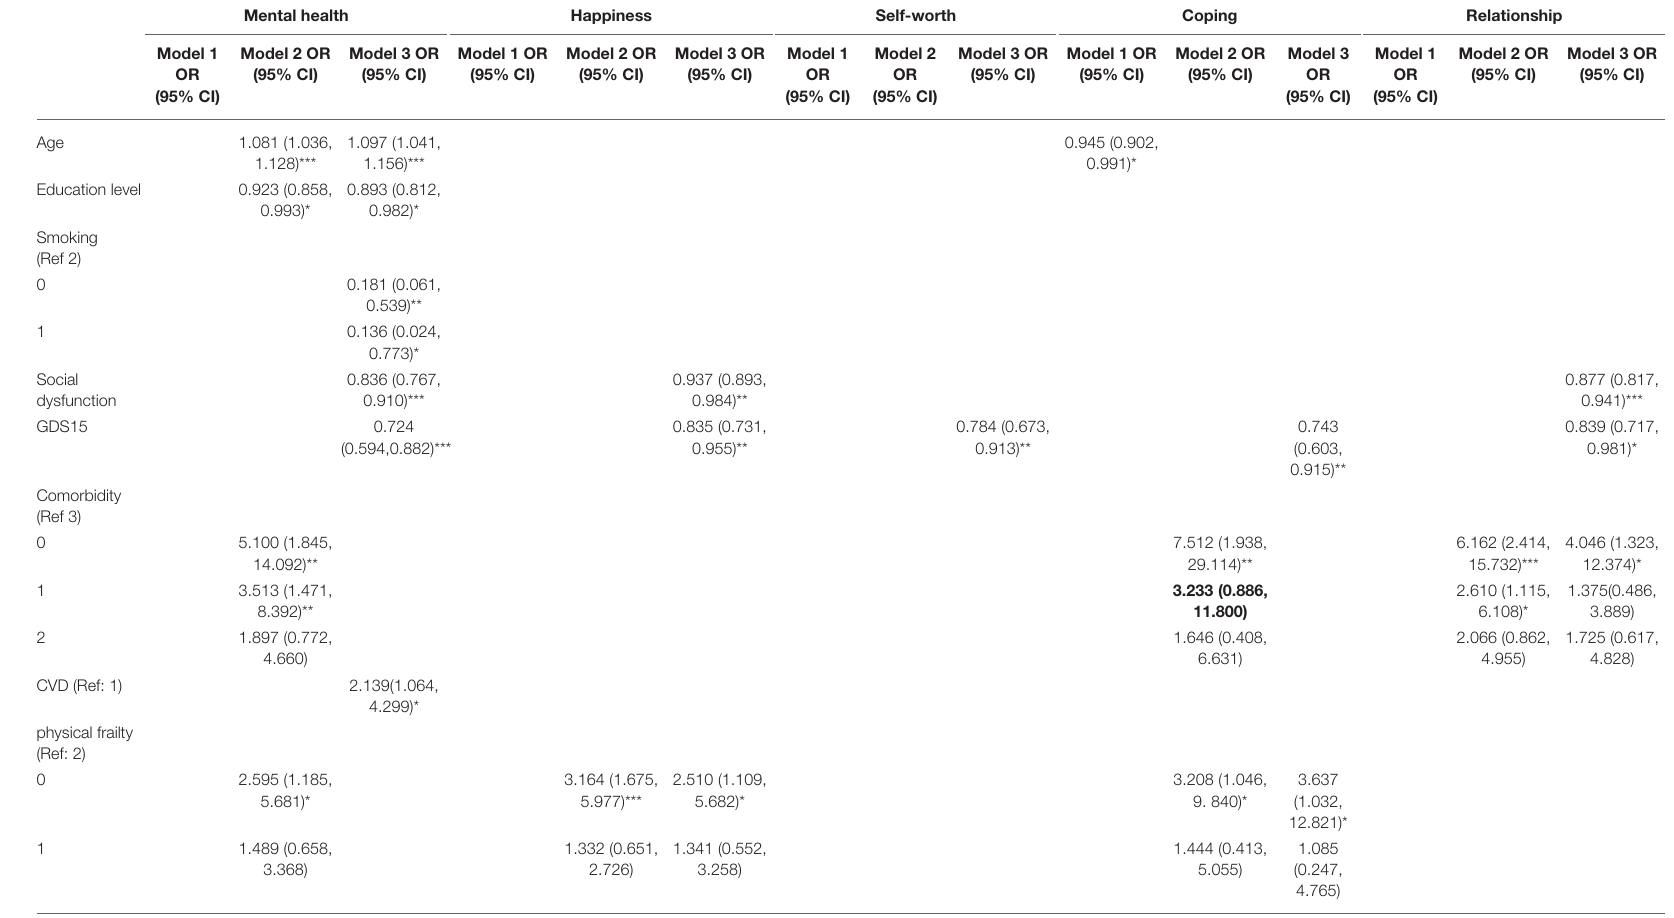
TABLE 7 | Multiple logistic regression analysis of the association of the presence of ARHL and/or tinnitus and psychological dimension of